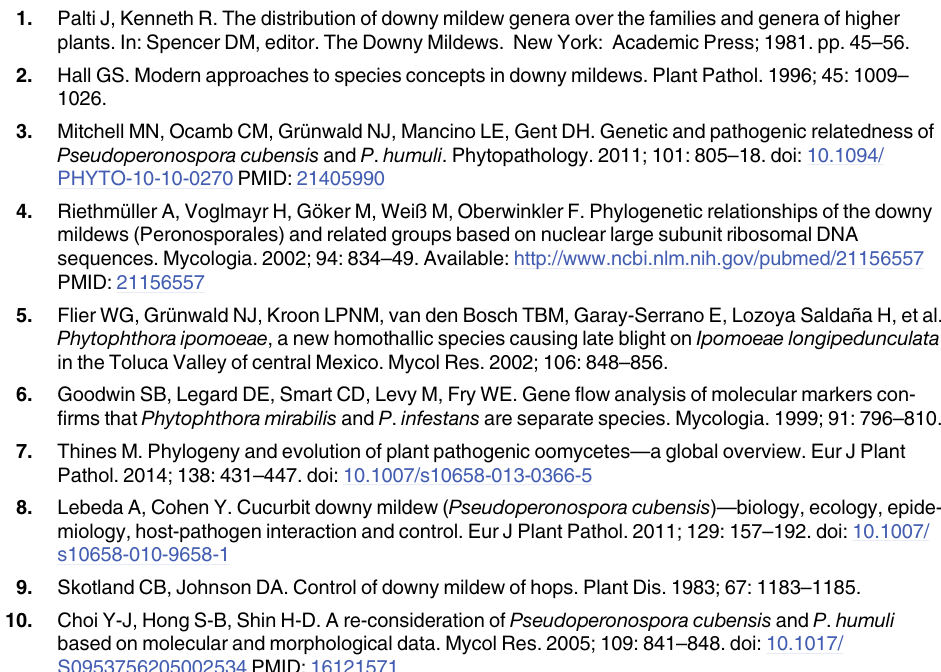
S1 Table. Percent host contamination from total barcoded, unaligned reads for RNA-seq and GBS. S2 Table. Depth and missing data statistics from the filtered VCF files from RNA-seq and GBS data and two filtering strategies, where either the maximum number of SNPs or the maximum number of isolates were retained. S3 Table. Unigenes containing PCA-correlated SNPs identified in both RNA-seq and GBS